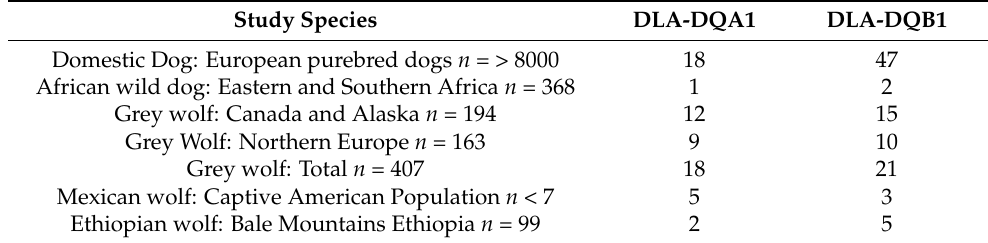
Table 1. Comparison of the number of the major histocompatibility complex class II, DLA-DQA1, and DLA-DQB1 (dog leukocyte antigen-DQ α 1 and β 1 respectively) alleles found in different canid populations